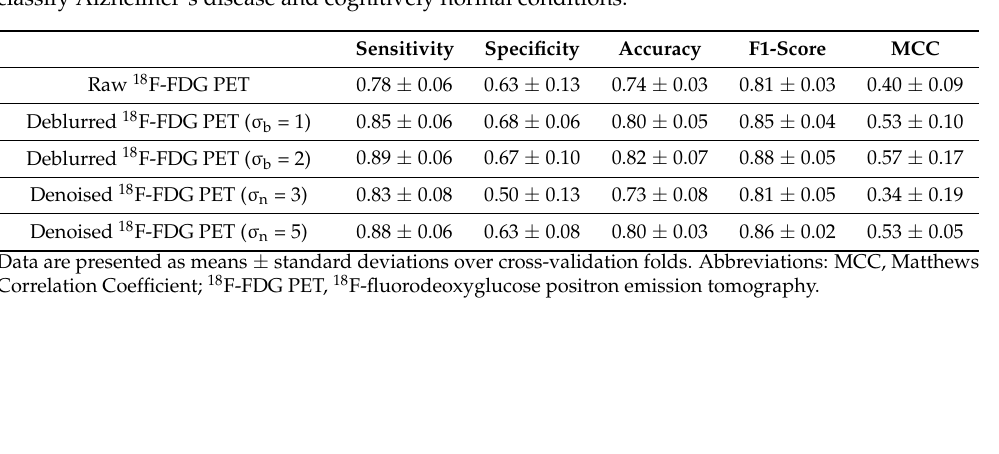
Table 2. Performance comparison of an individual classification model trained by raw, denoised, or deblurred whole-brain 18 F-FDG PET images for the classification of Alzheimer’s disease and cognitively normal conditions.